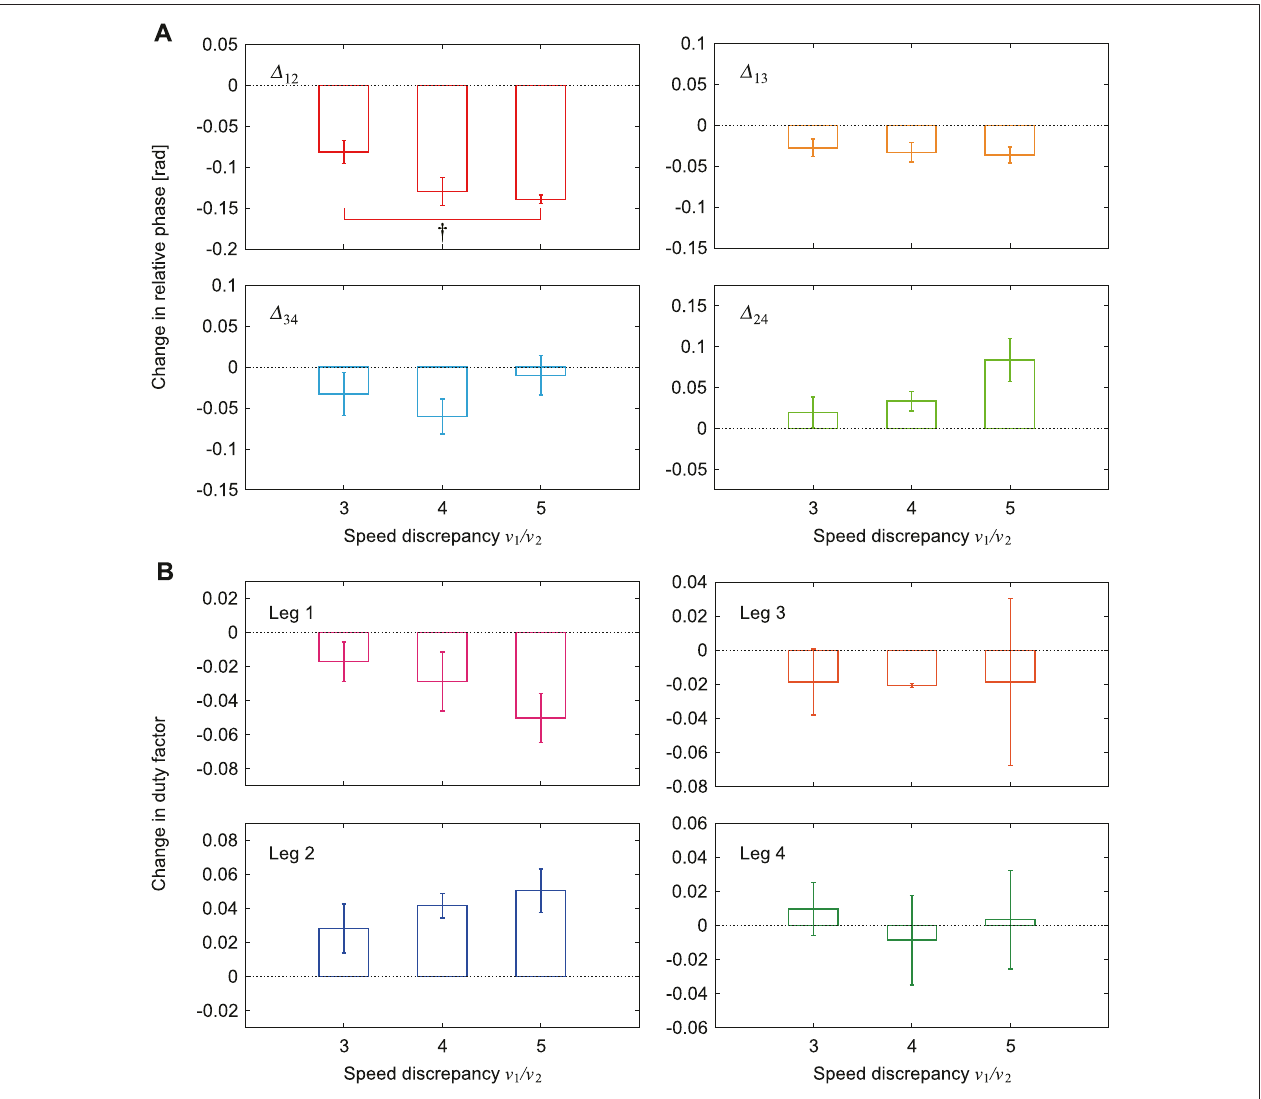
FIGURE6| Changesinaverage (A) relativephasesand (B) dutyfactorsbetweentiedandsplit-beltcon fi gurationsfor3x,4x,and5xconditions( v 1 / v 2 (cid:1) 3,4,and5). Data points and error bars are the mean and standard error results of fi ve experiments, respectively. † : p < 0 . 05.